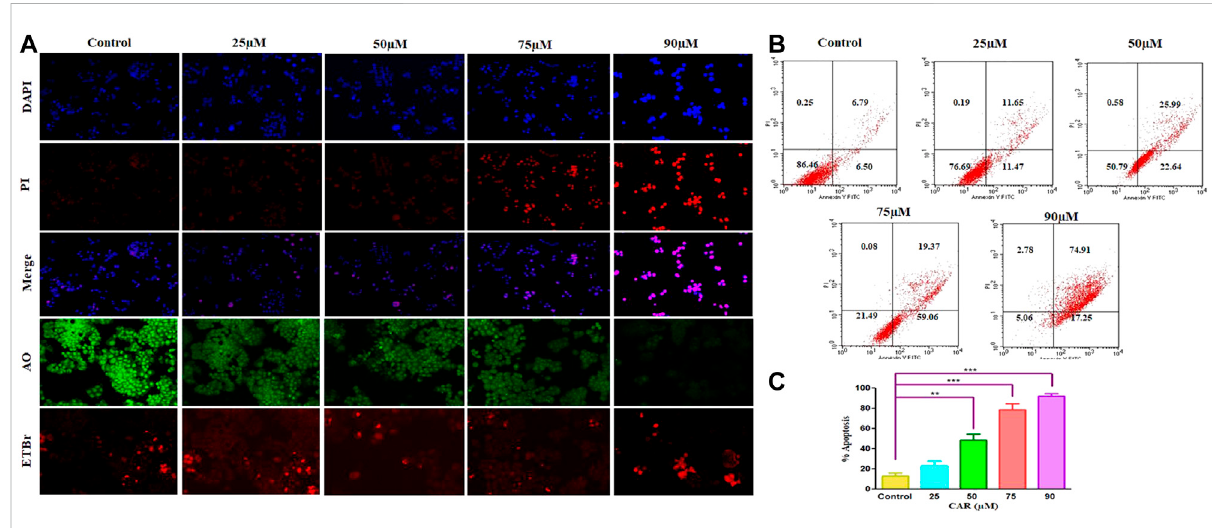
FIGURE 3 Detection of CAR-mediated apoptosis by fl uorescence microscopy in C33A cells. (A) C33A cells were treated with various concentrations of CAR for 24 h. Cells were stained with DAPI, PI, AO and EtBr as indicated on the left side of the panels. Fluorescent micrographs were captured at×20magni fi cation[scalebar=100 µm] (B) CellswereculturedwithvariousdosesofCARfor24 handanalyzedby fl owcytometryusingAnnexinV and PI dyes. (C) Graphical representation oftotal apoptosis induced in C33Acervical cancer cells during Annexin V-FITC/PI assay. Each value in the bar graph represents the mean ± SEM of three independent experiments. Signi fi cant difference among the treatment groups were analyzed by two tailed Paired Student ’ s t-test and one-way ANOVA followed by Dunnett post hoc test (* p < 0.05 , ** p < 0.01 , *** p < 0.001 represent signi fi cant difference compared with